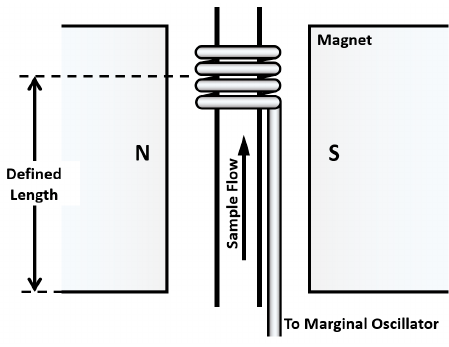
Figure 16. The experimental arrangement, described by Donnally, for measuring T 1 using a varied flow.